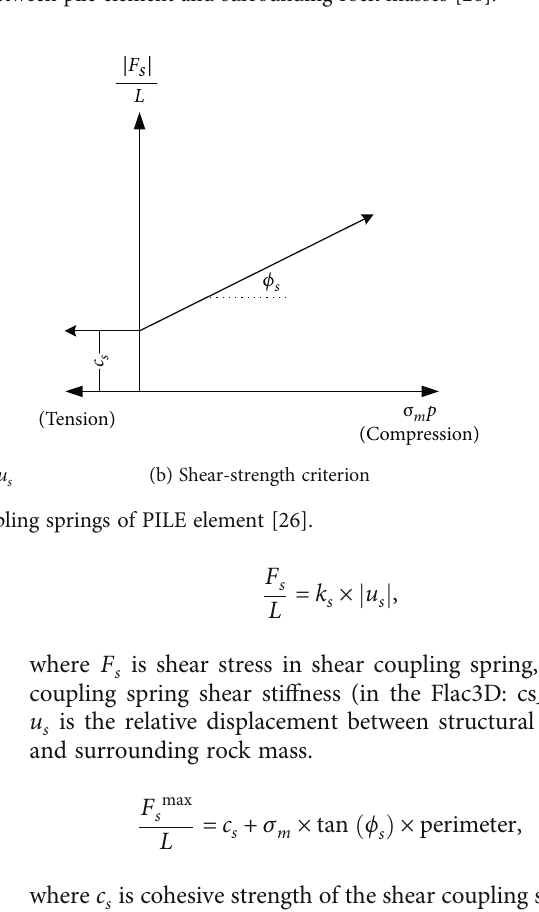
Figure 2: Mechanical properties of the interaction between pile element and surrounding rock masses [26].